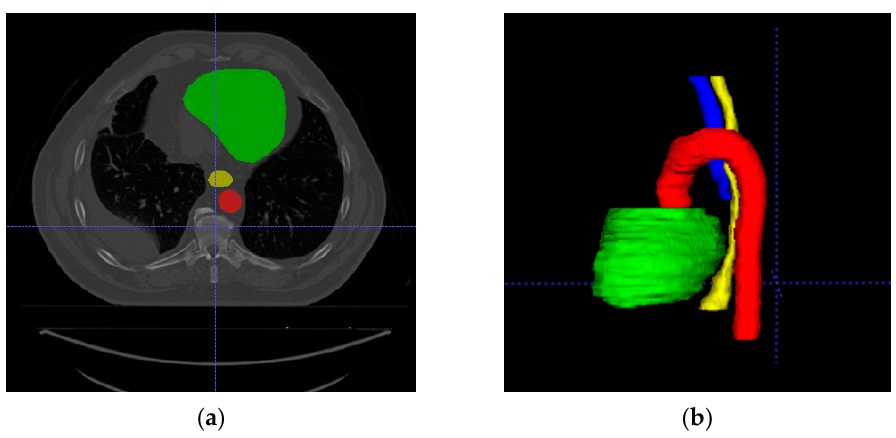
Figure 6. Example of OARs from SegTHOR ISBI 2019 dataset. ( a ) 2D image; ( b ) 3D image. Each OAR is shown in a different color. The green region is the heart; the yellow region is the esophagus; the blue region is the trachea; the red region is the